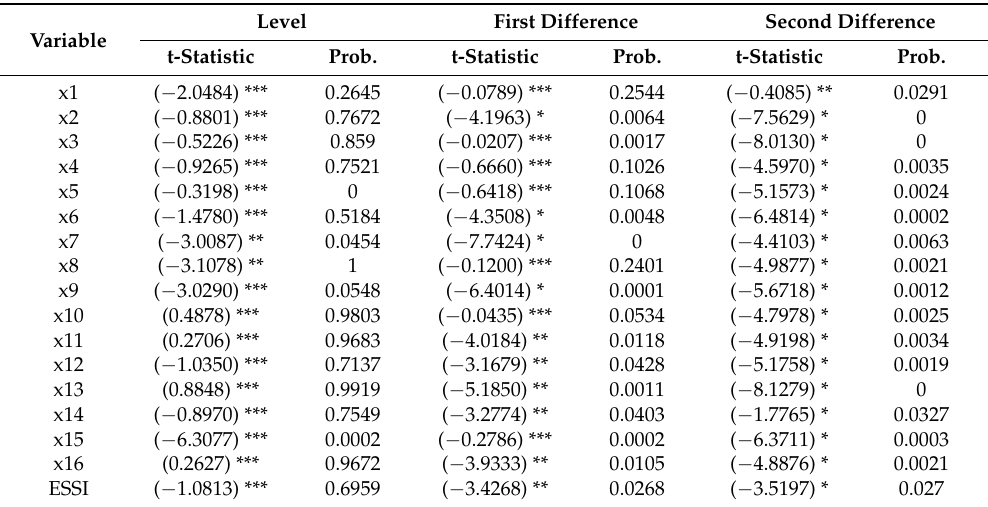
Table 7. Stationary tests.